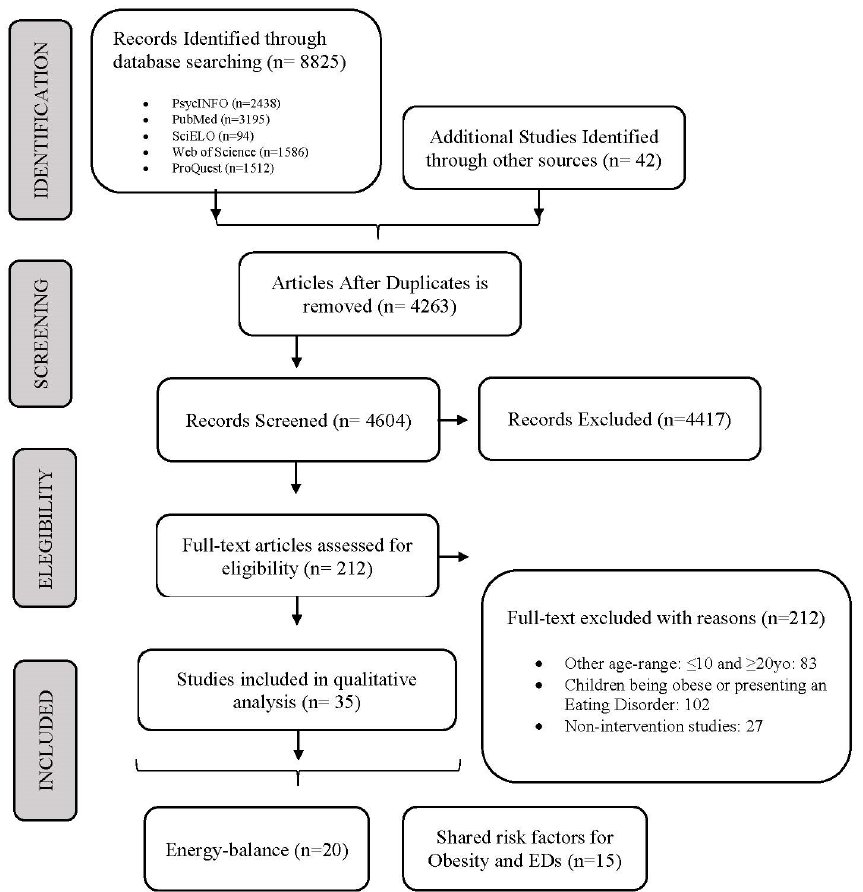
Figure 2. Flowchart showing the process of article selection.